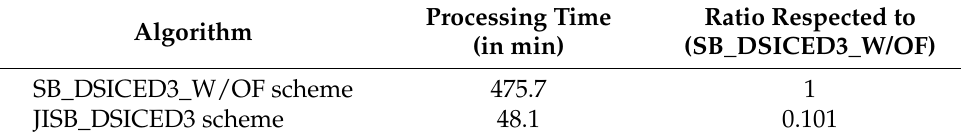
Table 3. Processing